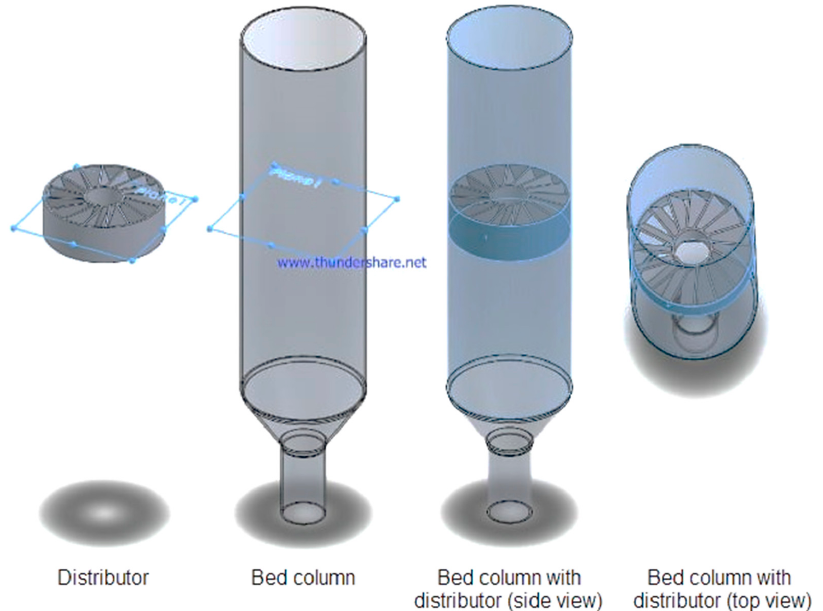
Figure 2. Complete design drawing of the bed